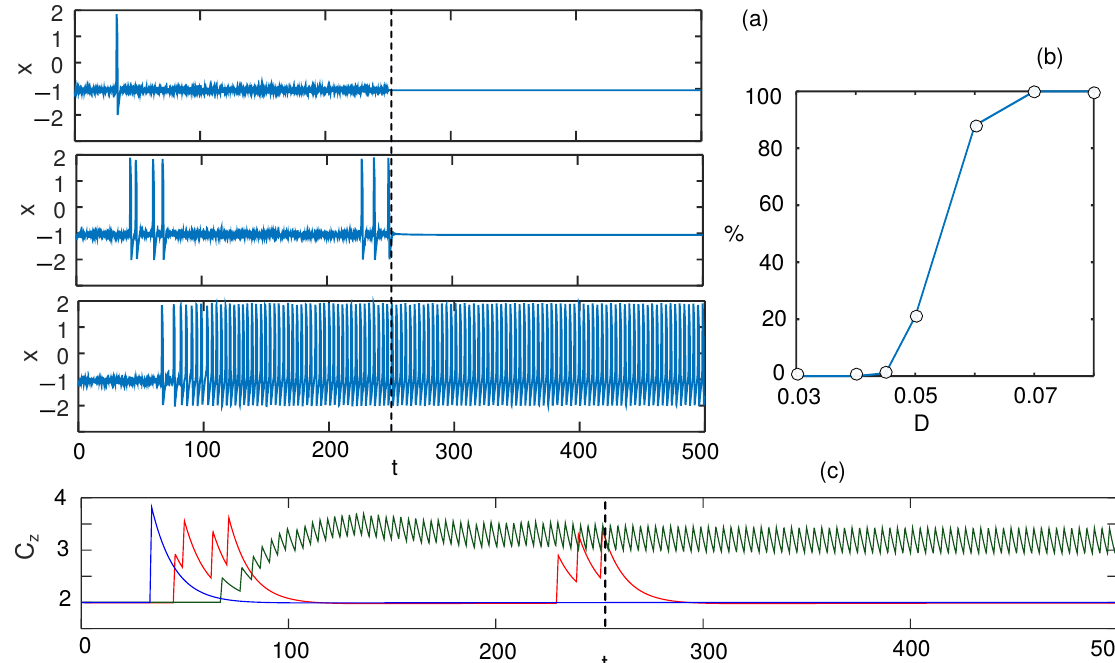
Figure 3. Noise-induced dynamics without the contribution of an astrocyte. Gaussian noise with D = 0.05 acts from t = 0 till t = 250. Panel ( a ) shows the model behaviors during three selected simulation runs; ( b ) the estimated percent of program runs where self-sustained dynamics appears after the noise was switched off; ( c ) C z behavior during three simulation runs shown in ( a ). For better visibility, time courses for the first and second cases are scaled by 4 and 2, respectively. All displayed quantities are